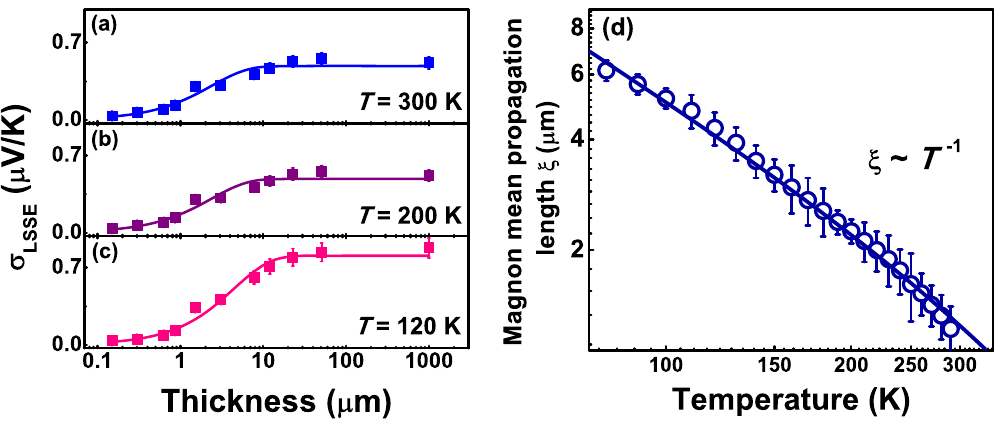
FIG. 2. Thickness-dependent σ measured at a fixed temperature of (a) 300 K, (b) 200 K, and (c) 120 K. The solid lines are the LSSE fitting results according to the atomistic spin model. (d) Temperature-dependent effective magnon propagation length ξ . The solid line is the fit to the power law of ξ ∼ T − n , where the fitted exponent n ∼ 1